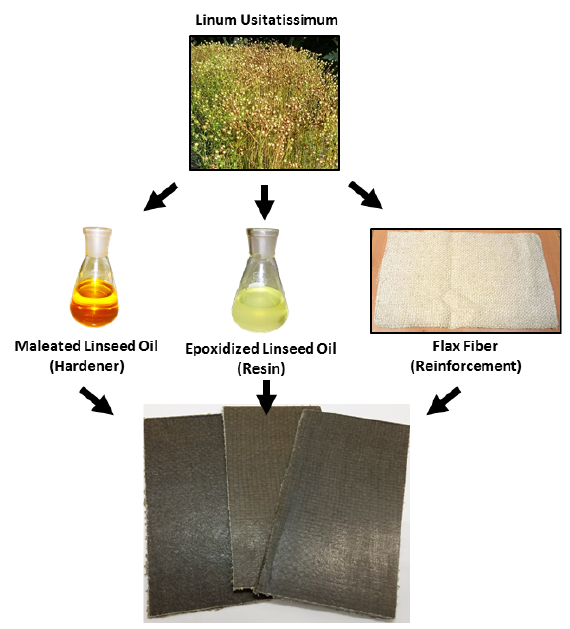
Figure 2. Multiple applications of linun usitatissimum in composite manufacturing.